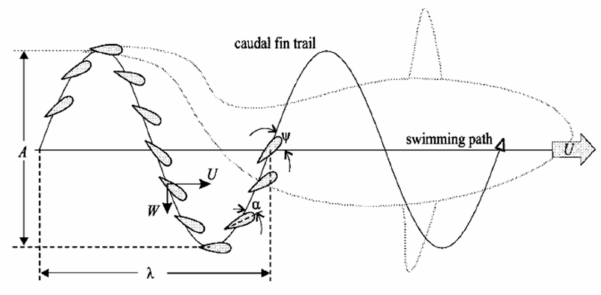
Figure 7. Caudal fins trajectories of